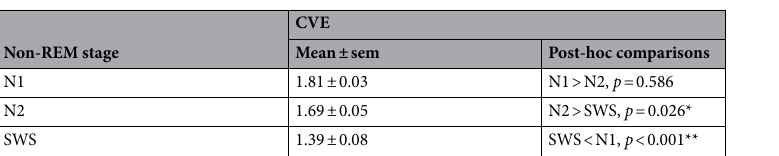
Table 3. CVE Values in Each non-REM stage (mean ± standard error). CVE coefficient of variation of the envelope. * p < 0.05, ** p <